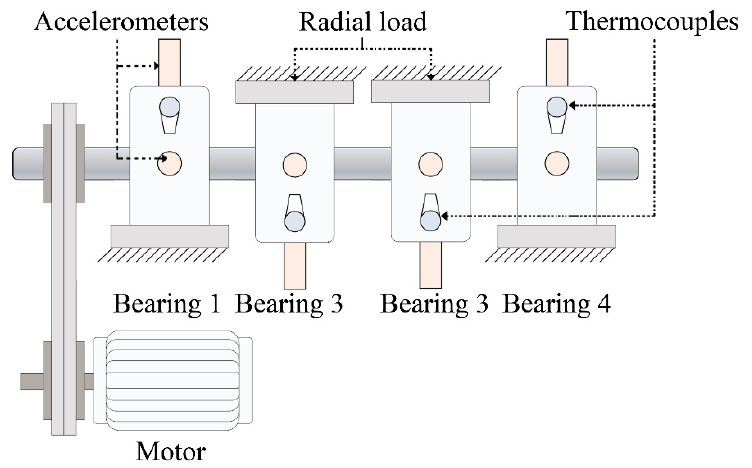
Figure 1. IMS bearing tests experimental setup.